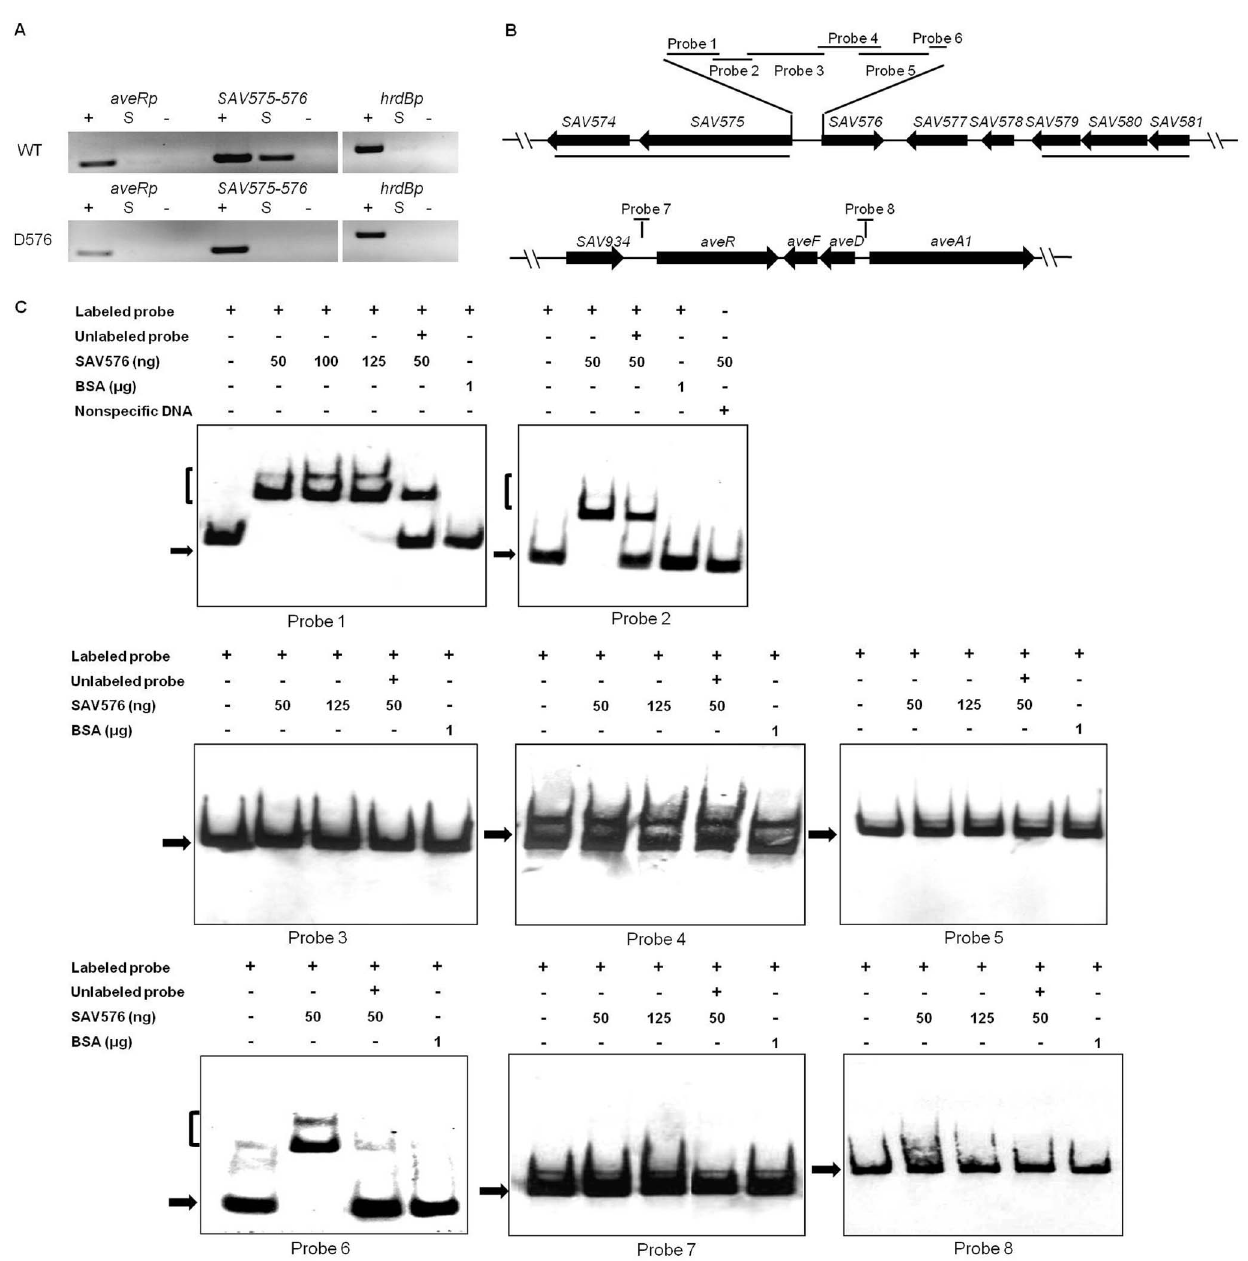
Figure 4. Analysis of SAV576 protein binding to target promoter regions. ( A ) ChIP assays in vivo . Anti-SAV576 antibodies were used to immunoprecipitate SAV576-DNA complexes from ATCC31267 and D576 cells treated with formaldehyde. The DNAs used for PCR were total DNA prior to immunoprecipitation (positive control: lanes ‘‘ + ’’), immunoprecipitated DNA (experimental sample: lanes ‘‘S’’), and negative control DNA without antibody (lanes ‘‘ 2 ’’). The hrdB promoter region was used as a control. ( B ) Schematic representation of the relative positions of probes used for EMSAs in vitro . Probe 1, 98-bp DNA fragment from + 2 to 2 96 relative to the translational start codon of SAV575 ; probe 2, 43-bp fragment from 2 98 to 2 140; probe 3, 276-bp fragment from 2 118 to 2 393; probe 4, 257-bp fragment from 2 306 to 2 562; probe 5, 333-bp DNA fragment from 2 533 to 2 865; probe 6, 43-bp DNA fragment from 2 866 to 2 908. Probe 7, 200-bp DNA fragment from 2 116 to 2 315 relative to the start codon of aveR . Probe 8, 328-bp DNA fragment from 2 14 to 2 341 relative to the start codon of aveA1 . Probes 7 and 8 cover the putative transcriptional start points of aveR and aveA1 , respectively. ( C ) EMSAs of the interaction of the probes with purified His 6 -SAV576 protein. Each lane contained 0.3 nM labeled probe. The labeled probe and an approximately 100-fold excess of the unlabeled probe were used in competitive assays. BSA was used as a negative control for SAV576 protein. Labeled non-specific DNA was used to eliminate non-specific binding of SAV576 protein. The free probes are indicated by solid arrows, and the retarded DNA fragments are indicated by parentheses. avermectin production in S. avermitilis . We are currently engaged in The expression of SAV576 was found to be autoregulated. characterization of other differentially expressed regulatory genes However, the differing transcription levels of SAV576 at various life revealed by transcriptome analysis. stages indicate that the regulation of SAV576 expression is complex